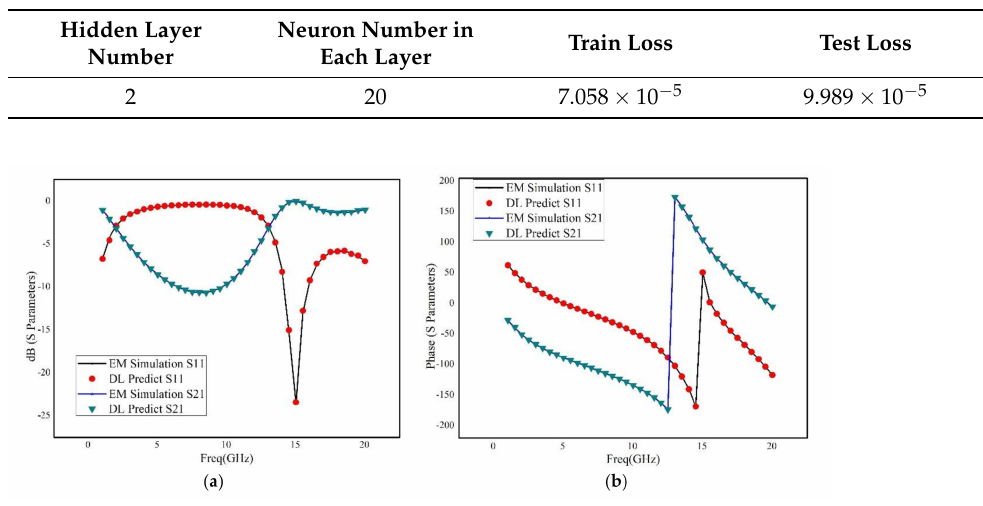
Table 7. Train and test loss of neural network.